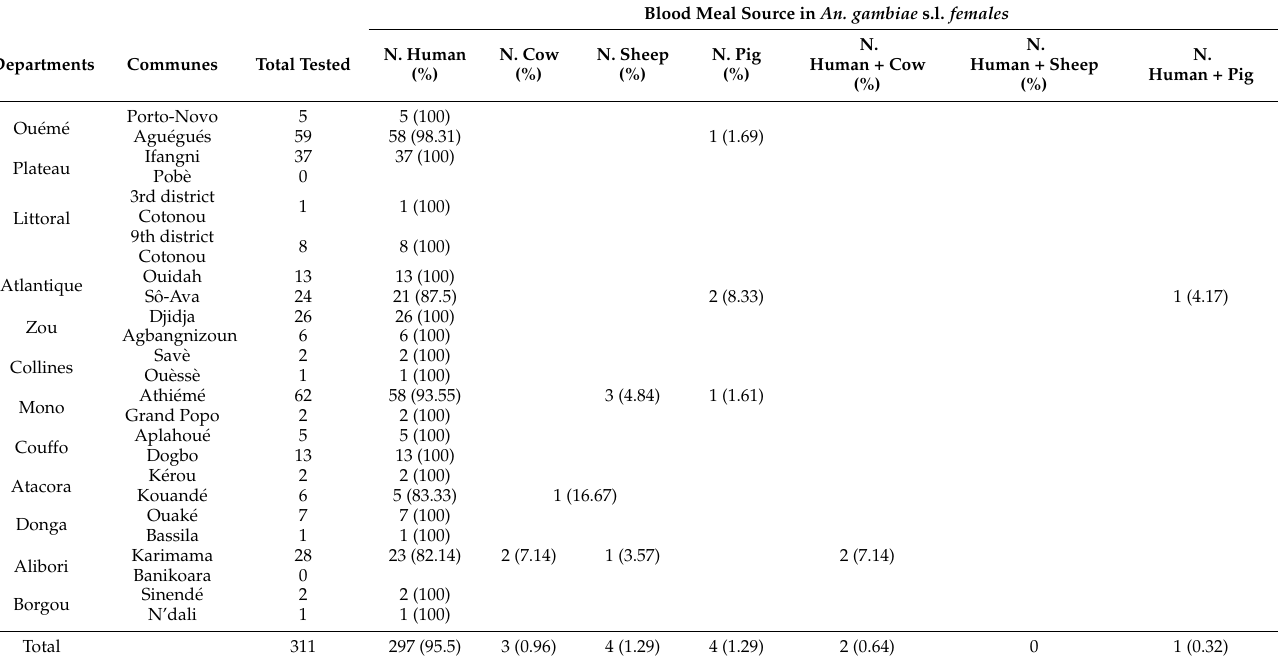
Table 3. Blood meals source in An. gambiae s.l. females collected in Benin departments. Blood Meal Source in An. gambiae s.l.